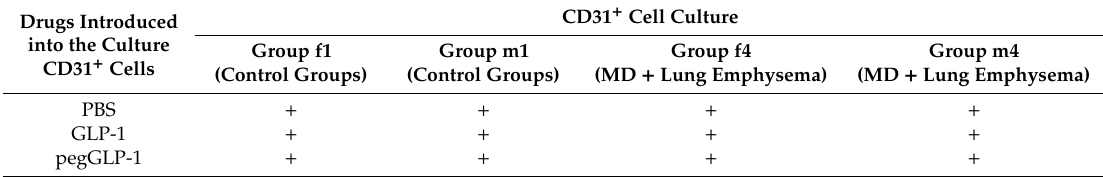
Table 2. Experimental groups in